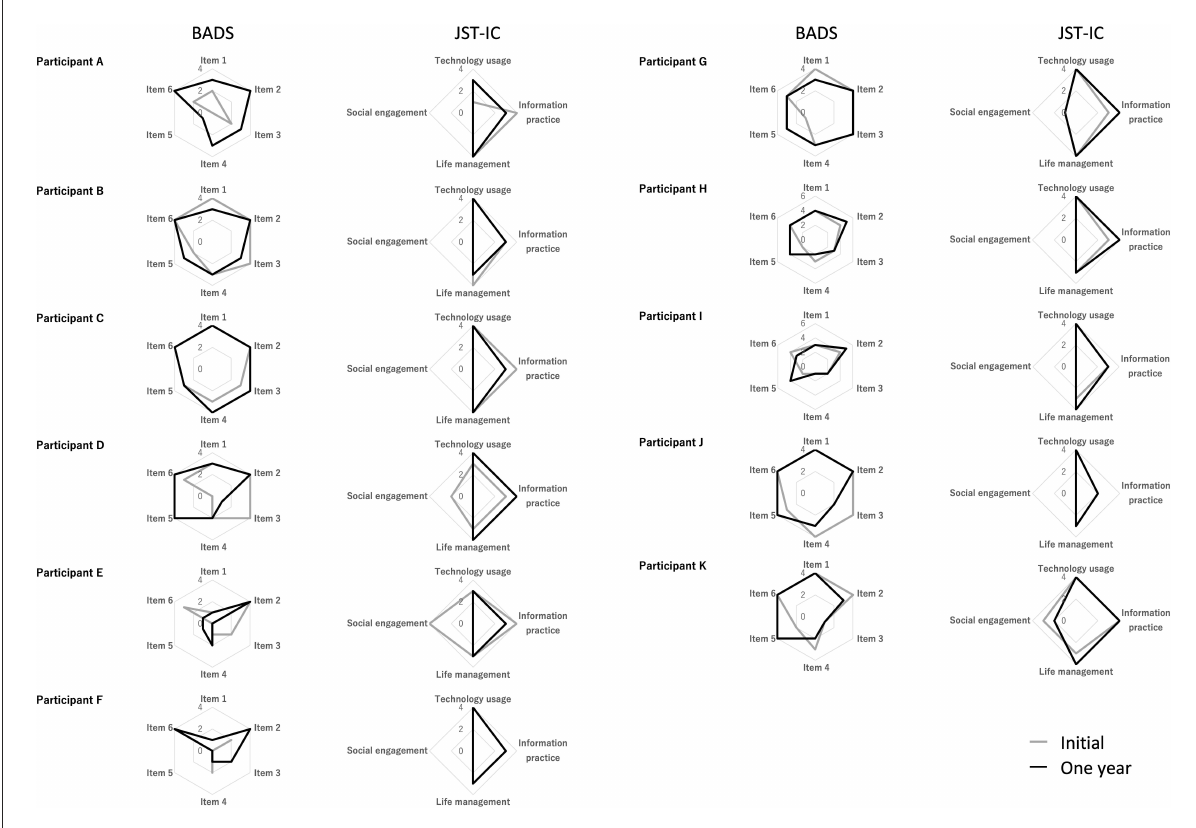
FIGURE1 Radar charts of BADS and JST-IC scores at the initial assessment and 1 year